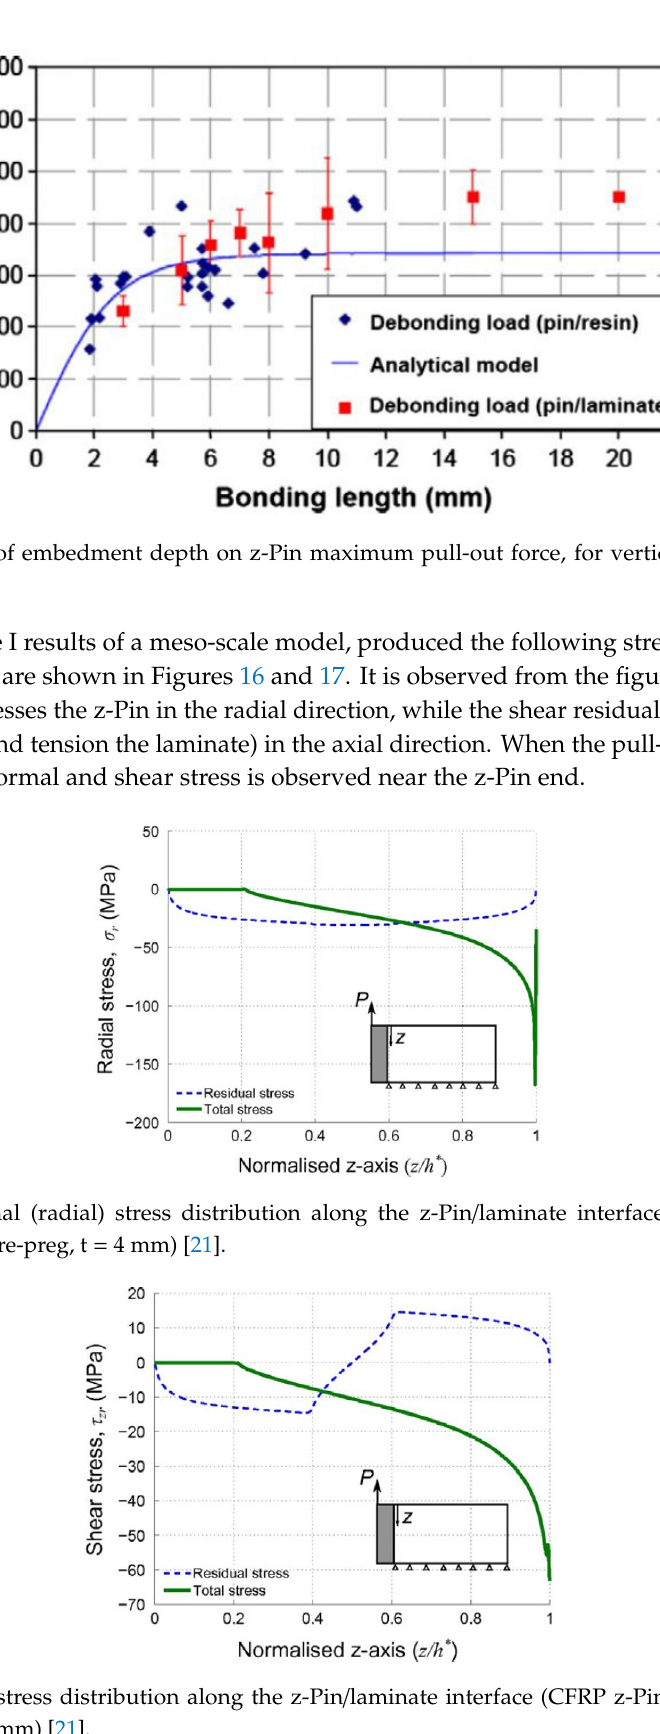
F igure 18. Effect of z-Pin diameter on mode II z-Pin response (CFRP z-Pins, t = 2 h = 4 mm, [0] pre-preg) [23].